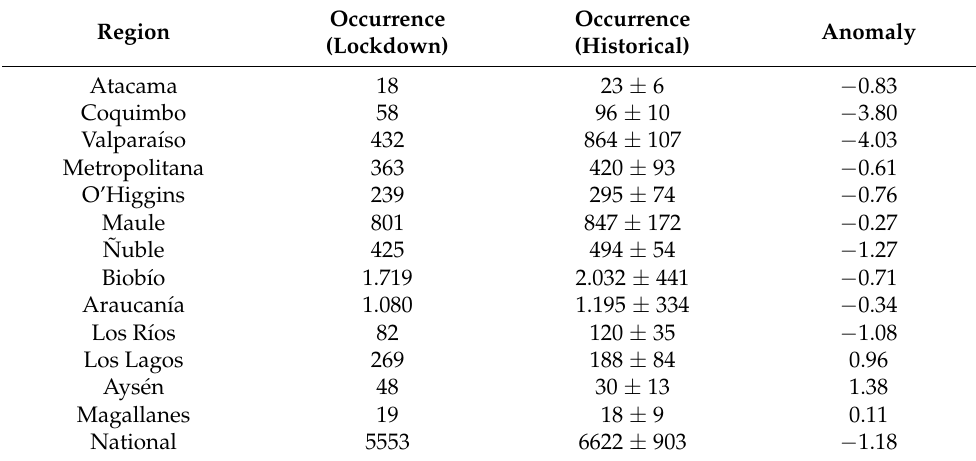
Table 1. Current wildfire occurrence anomaly (15 May 2020–15 May 2021), under mobility restriction, and